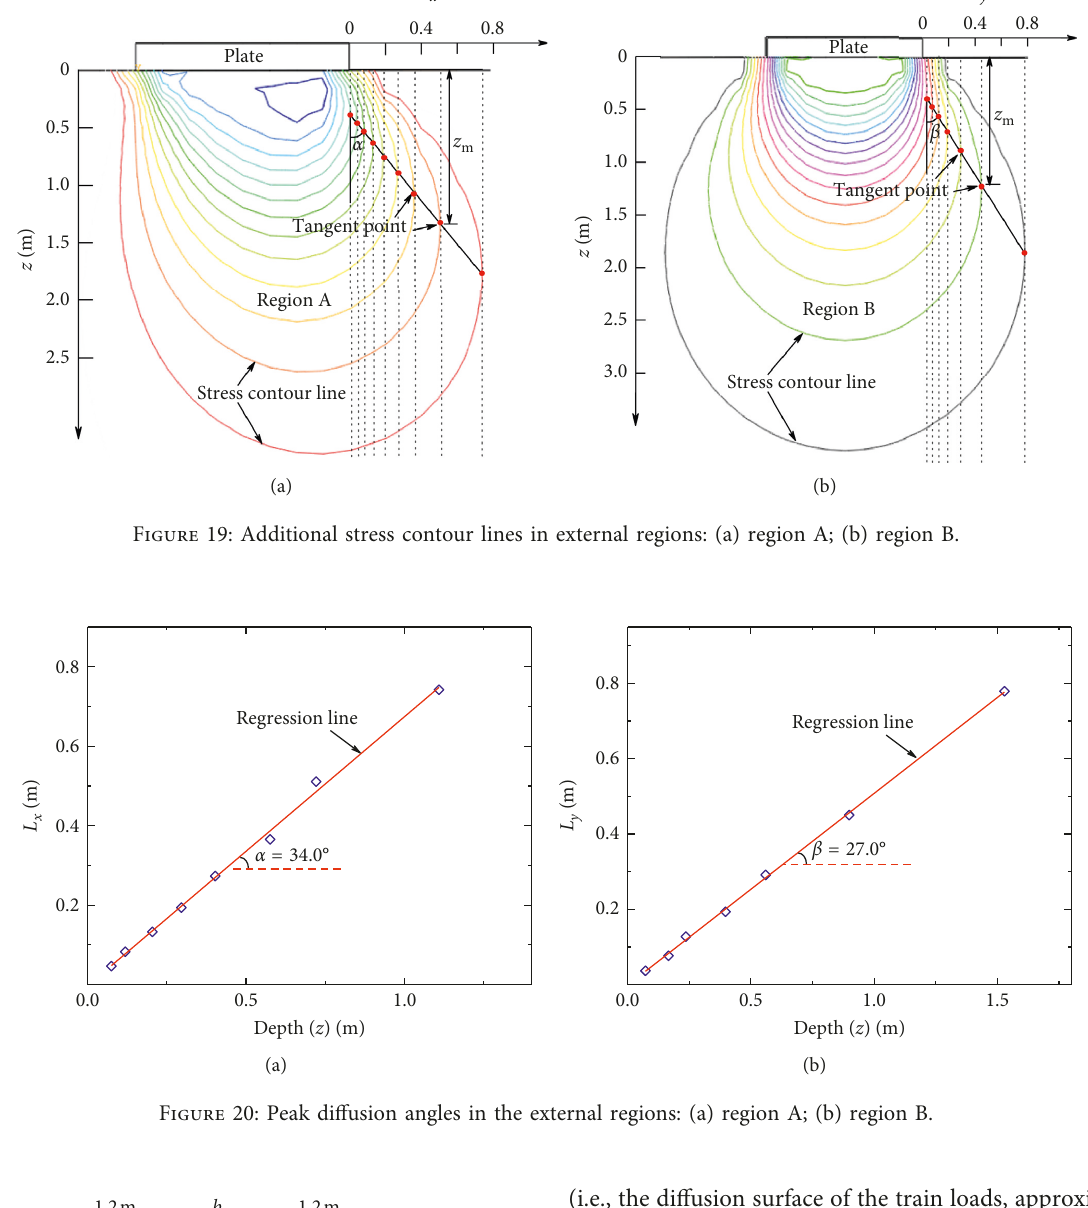
Figure 20: Peak diffusion angles in the external regions: (a) region A; (b) region B.